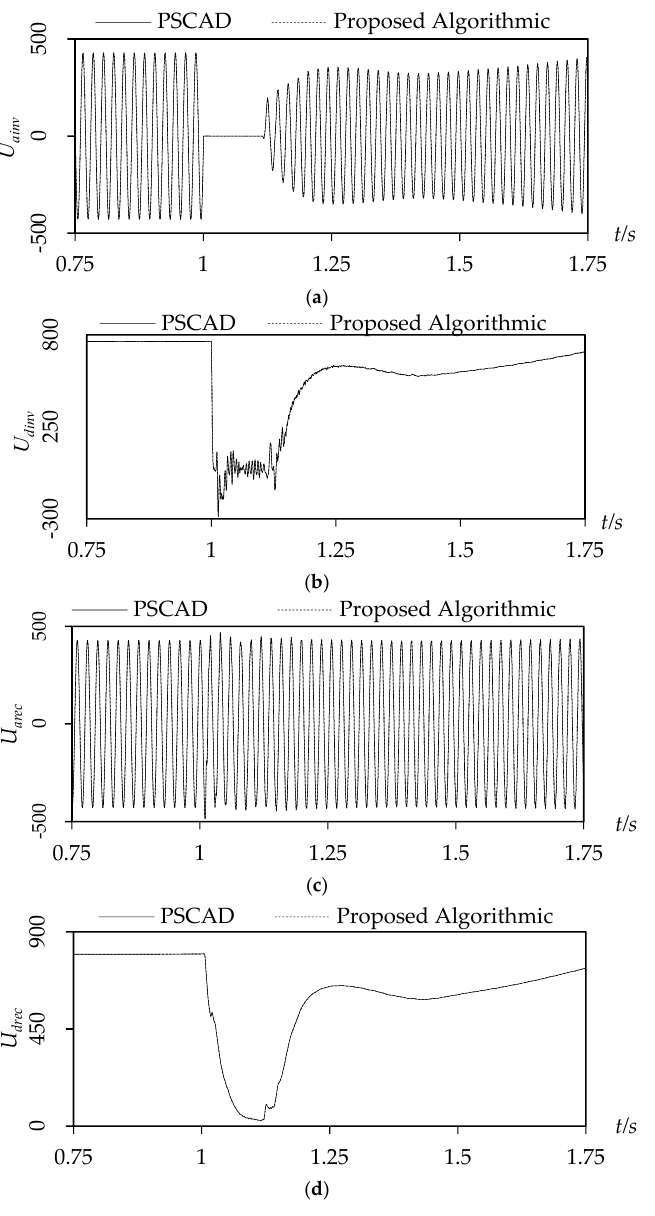
Figure 5. Comparison of the simulation results: ( a ) simulation comparison of U ainv ; ( b ) simulation comparison of U dinv ; ( c ) simulation comparison of U arec ; and ( d ) simulation comparison of U drec .